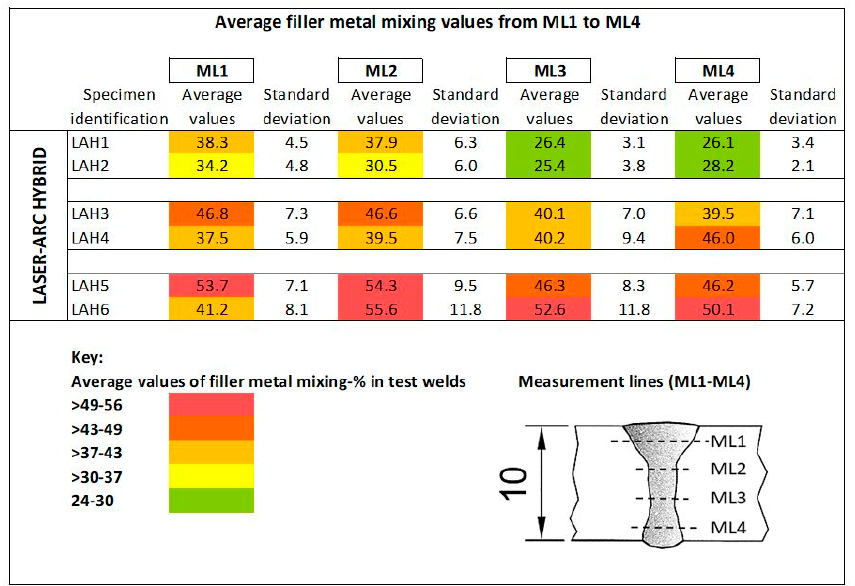
Figure 10. Average values of filler metal mixing-% from the data of measurement lines ML1–ML4 in laser-arc hybrid test welds.